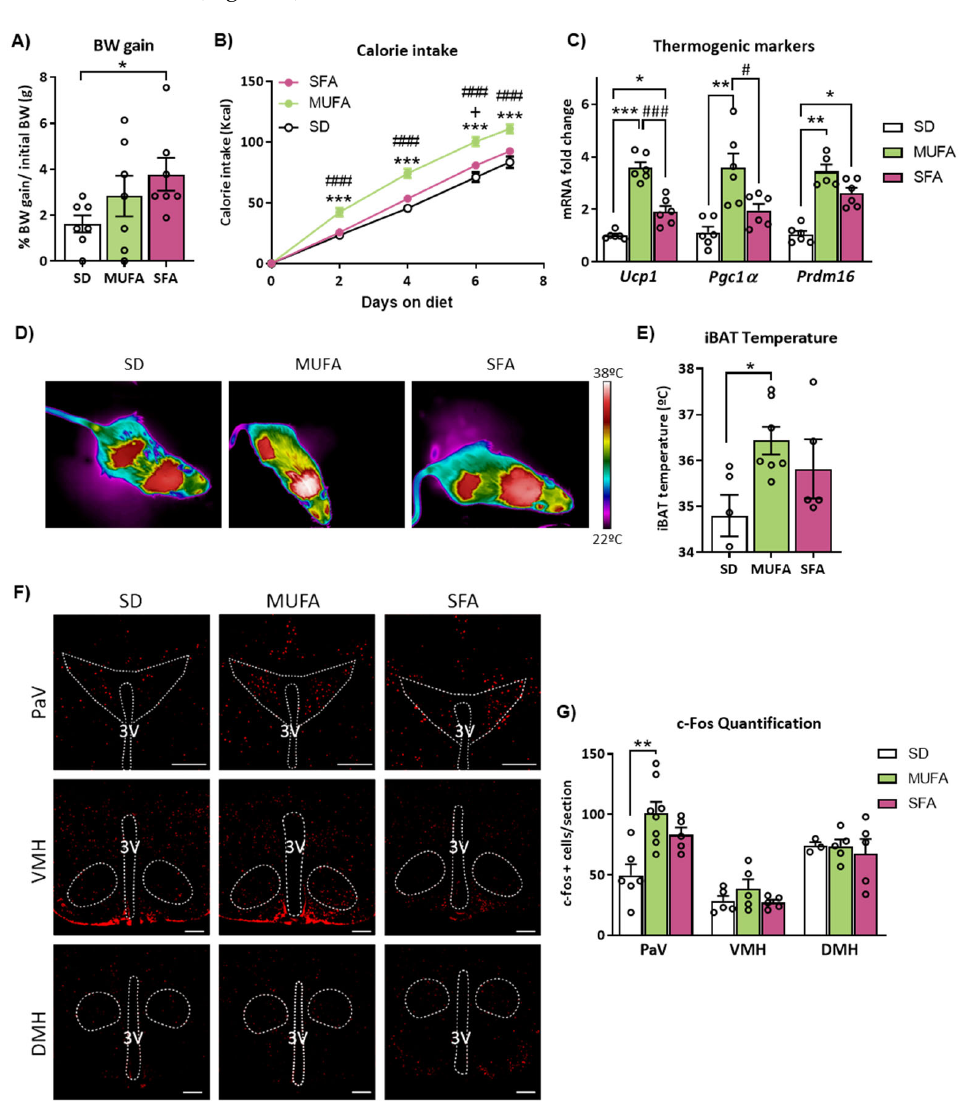
Figure 1. Effects of short-term administration of SD-, MUFA- and SFA-enriched diets in body weight, feeding, brown adipose tissue (BAT) thermogenesis and neuronal activation in the hypothalamus of WT mice . ( A ) Body weight (BW) gain normalized to the initial body weight measured, ( B ) cumulative caloric intake, ( C ) and mRNA expression of the thermogenic markers in BAT after 7 days on special diets. ( D ) Representative infrared pictures and ( E ) quantification of interscapular BAT (iBAT) temperature after 7 days on special diets. ( F ) Representative images and ( G ) quantification of immunohistochemistry for c ‐ Fos expression in PaV, VMH and DMH after 2 h exposition to the special diets. Data are represented as mean ± SEM (n = 7 animals in body weight, food intake and thermogenesis activity measurement, n = 4 animals per group in c ‐ Fos experiment). * p < 0.05,